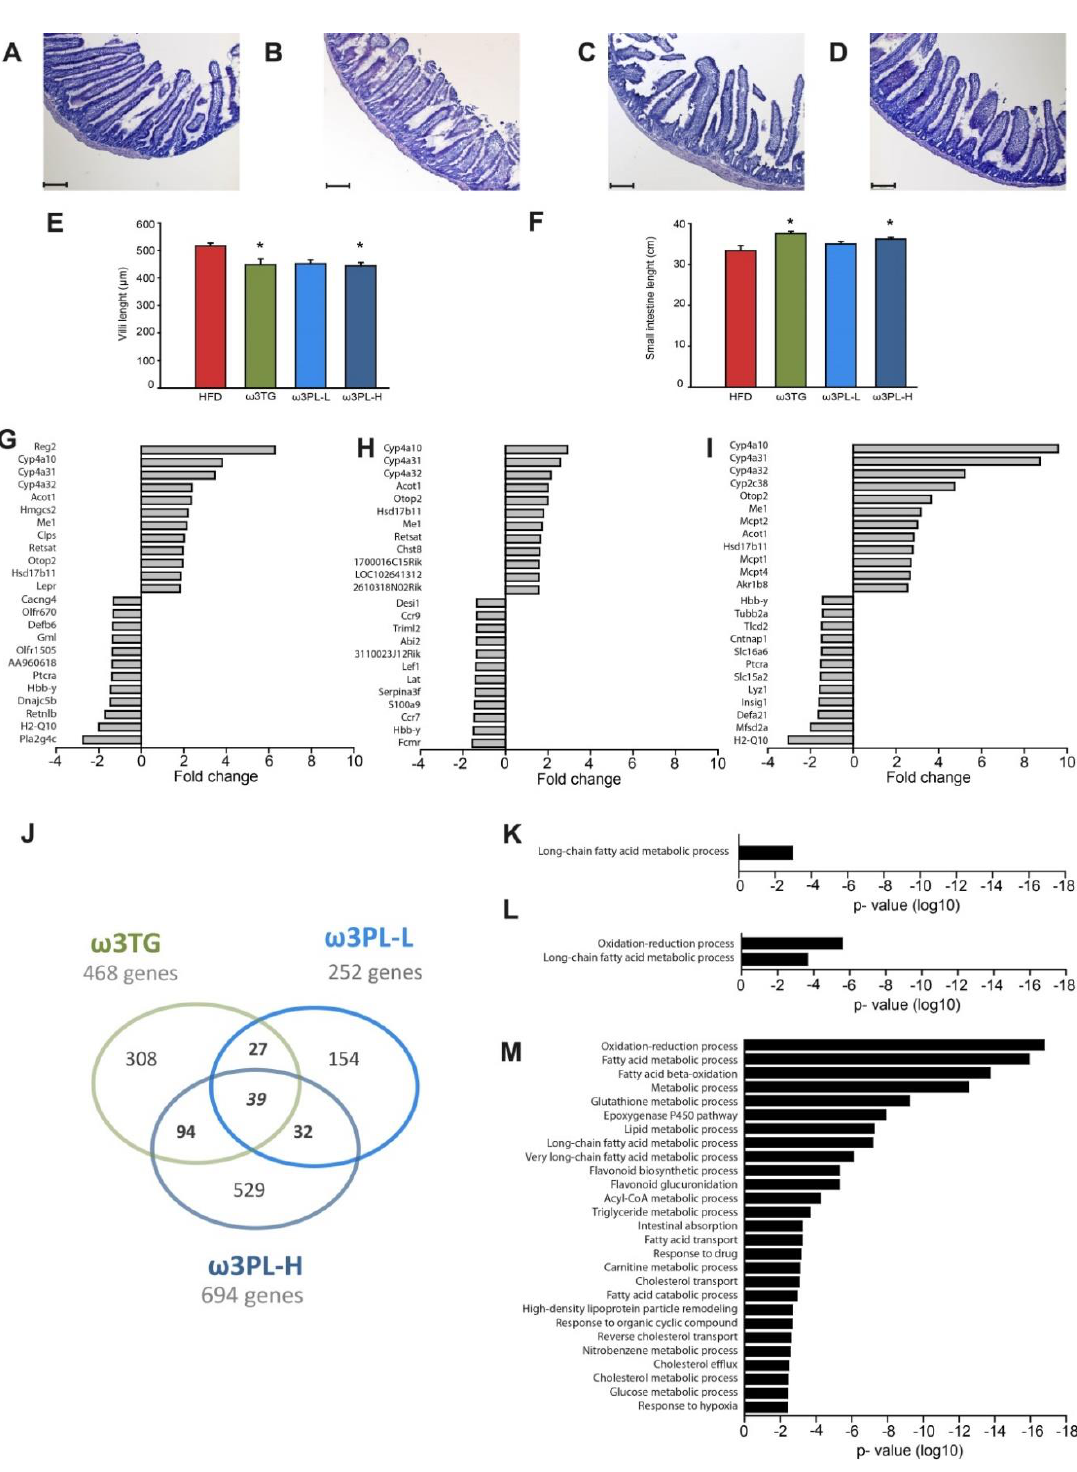
Figure 4. Small intestine as target of Omega-3 dietary intervention in dietary obese mice. ( A – D ) Representative hematoxylin-eosin sections of proximal ileum from HFD ( A ), ω 3TG ( B ), ω 3PL-L ( C ) and ω 3 PL-H ( D ) mice; original magnification, 100x; scale bar, 200 µ m ( E ) Length of villi in proximal ileum and ( F ) length of small intestine of mice fed HFD with and without supplementation for 8 weeks. Data are means ± SEM ( n = 8). *, significantly di ff erent vs. HFD; #, significantly di ff erent vs. ω 3TG; † , significantly di ff erent vs. ω 3PL-L ( p < 0.05, one-way ANOVA). ( G – I ) The 12 most up- and down- regulated genes compared to HFD as assessed by microarray analysis in whole length of small